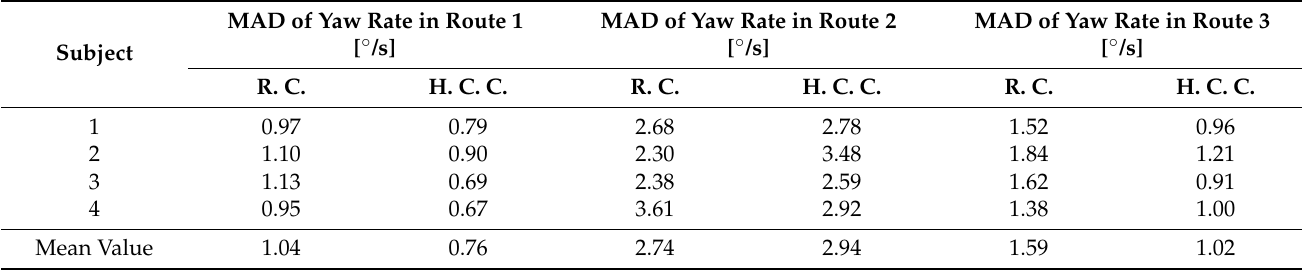
Table 2. Mean absolute deviation (MAD) of yaw rate of each subject in remote control and human–machine cooperative control mode in three